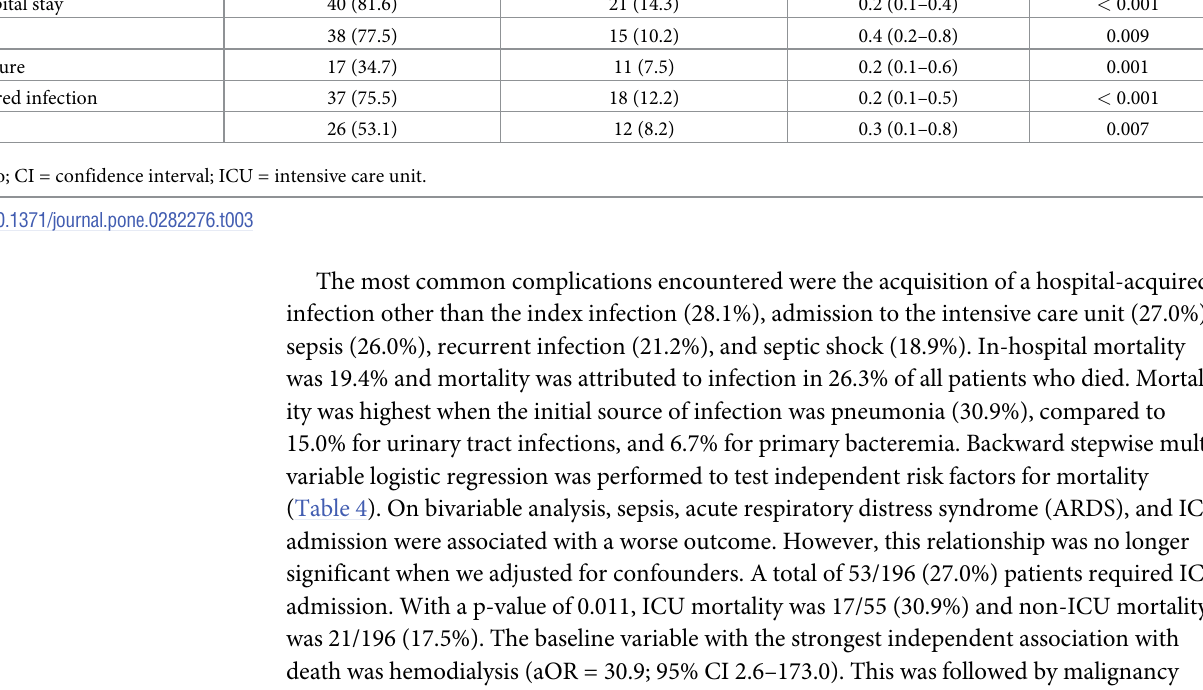
Table 4. Bivariable and multivariable analysis of predictors of mortality among patients with P . aeruginosa infection. Risk